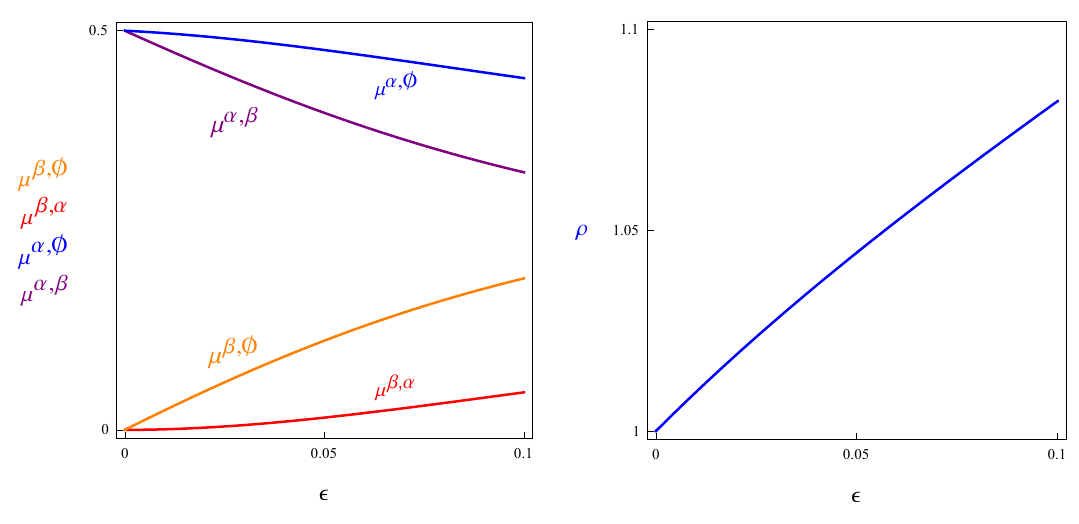
Figure 1. The left panel describes the steady state fractions µ χ,χ (cid:48) of types in the population with suicide. The right panel illustrates ρ , the steady state per capita reproductive resources in the population with suicide. All variables are described as functions of (cid:15) , letting α = 1 . 5 and β = 1 . 2